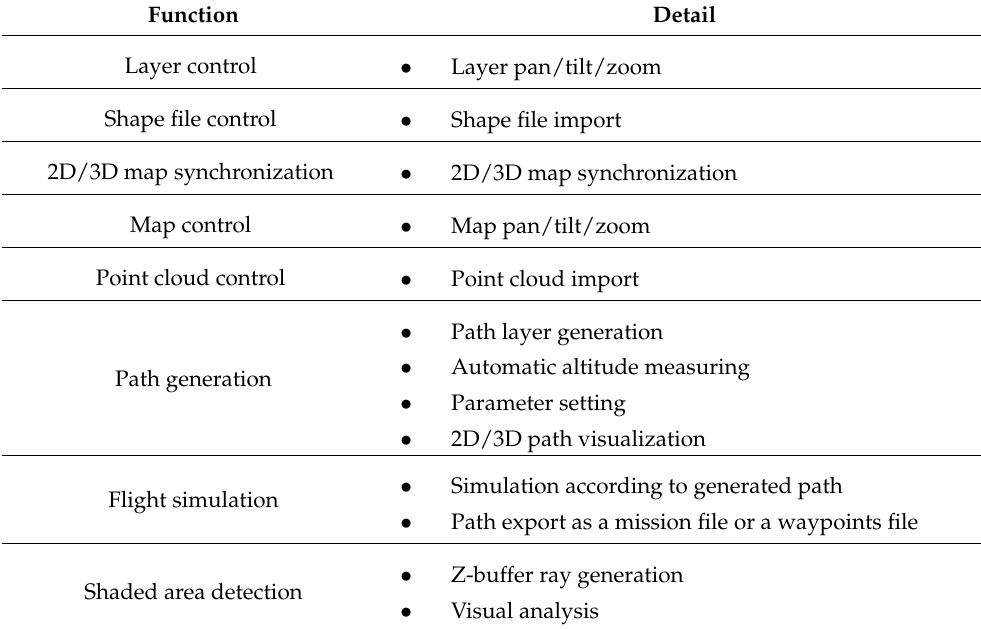
Table 1. Functions and details for the UAV photogrammetry simulator.